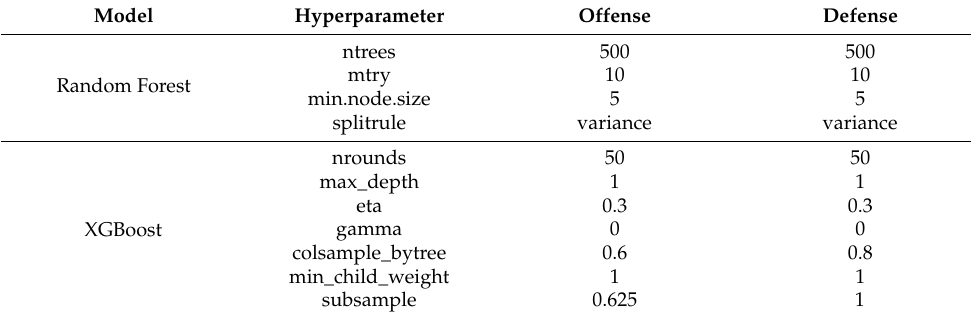
Table 3. Values of the hyperparameters for the random forest and XGBoost models for offense and defensive